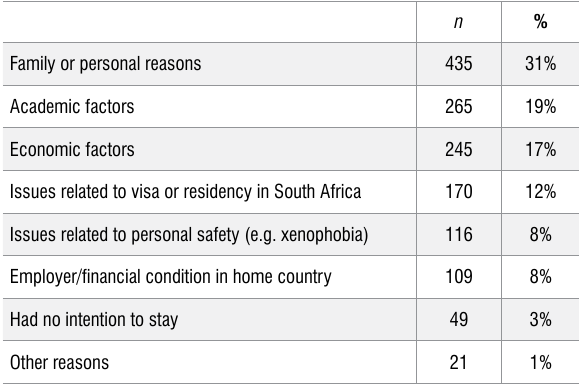
Reasons given by doctoral graduates from Africa for leaving South Africa after obtaining a doctorate